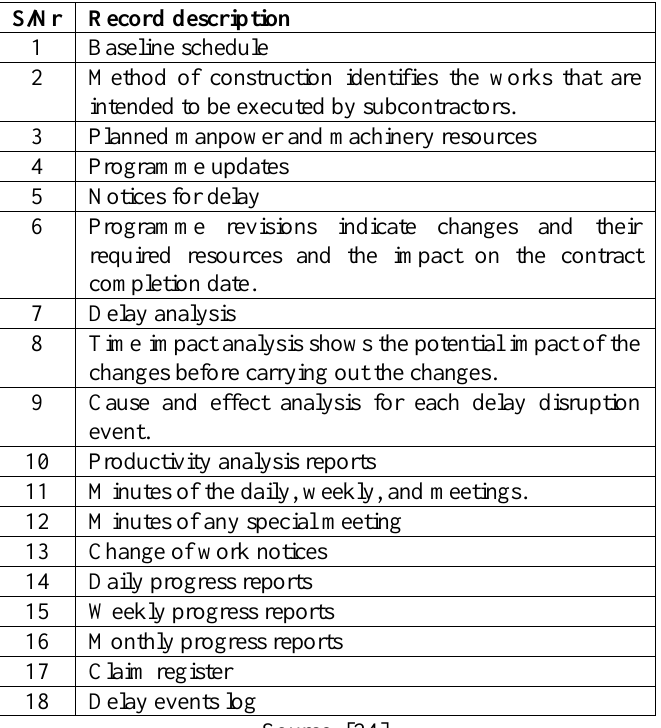
Table 1: List of required records to establish properly substantiated claim.